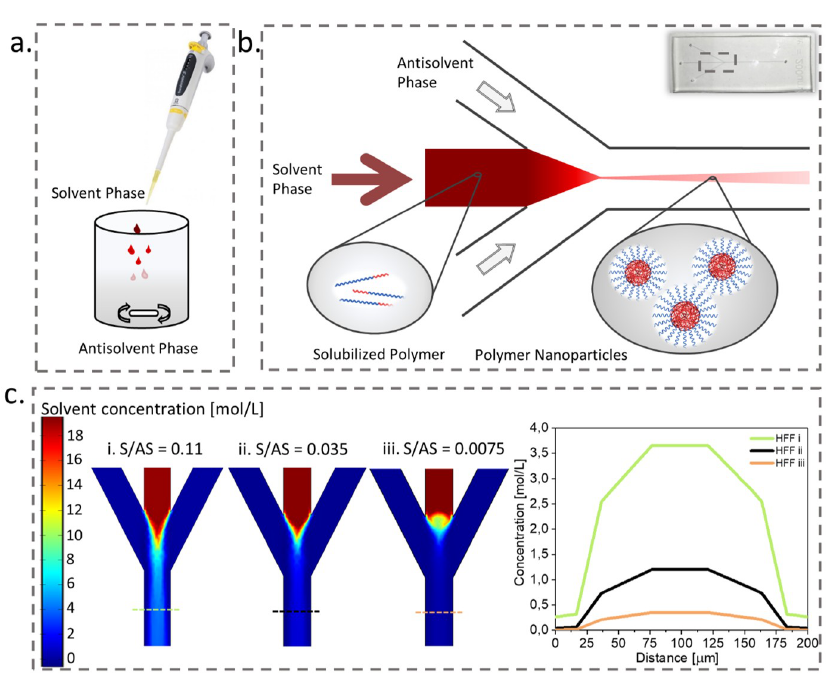
Fig 1. Formulation of nanoparticles via nanoprecipitation. a. manual bulk mixing, b. hydrodynamic flow focusing, c. fluid dynamics simulation for three different solvent to antisolvent flow rates (S/AS)and the solvent concentration (i- iii) at the outlet cross-section 0,3 mm below the junction (marked by the dashed line in the simulations on the left).